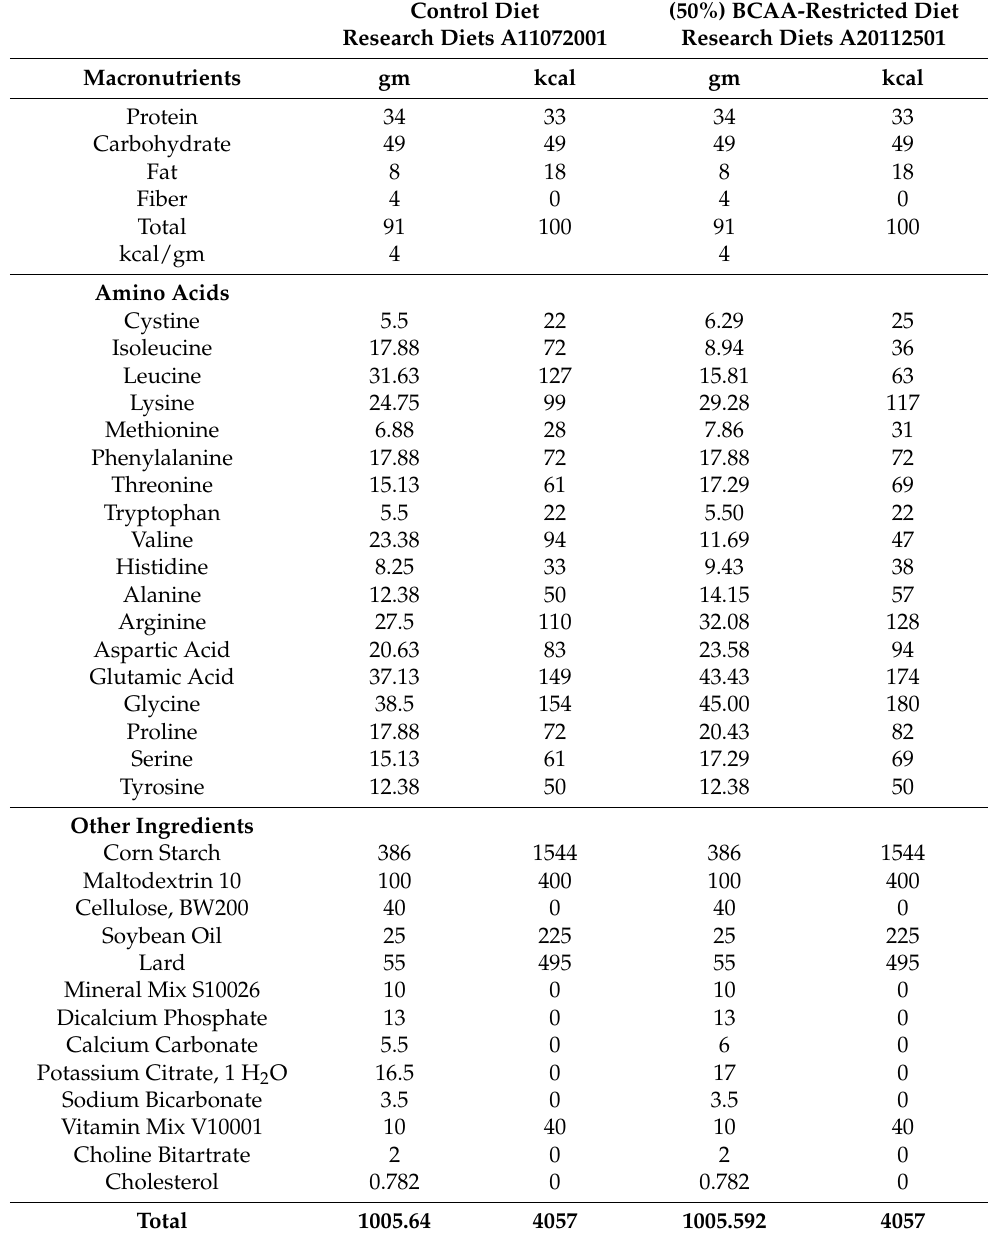
Table 1. Detailed nutrient composition in Control diet and customized, 50% BCAA-restricted